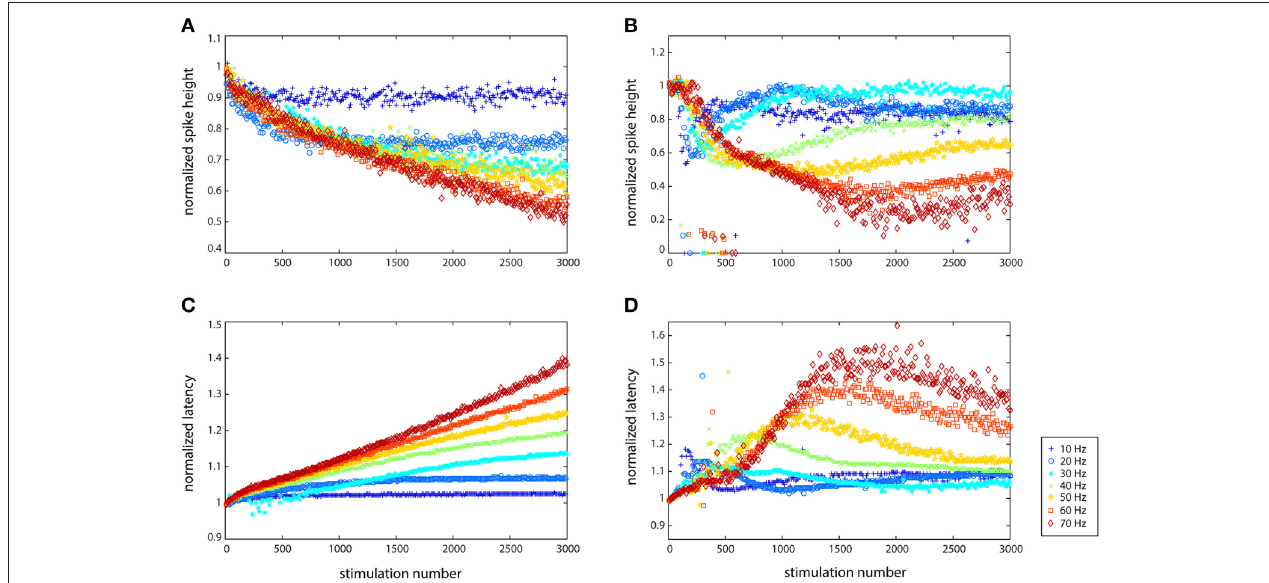
FIGURE 3 | Cells reacted differently to stimulation depending on their spontaneous characteristics (rate and spiking type) with regard to spike height (A,B) and spike latency (C,D). Data from two different cells is shown here. (A,C) Largely linear responses of the axon of one cell (cell 9123 in Figure 4 ), especially with regard to latency. (B,D) Adaptive behavior of another cell (cell 1237 in Figure 4 ), which responded non-linearly at every stimulation frequency that it was subjected to, but then recovered more (10Hz) or less (70Hz) in terms of both spike size and latency